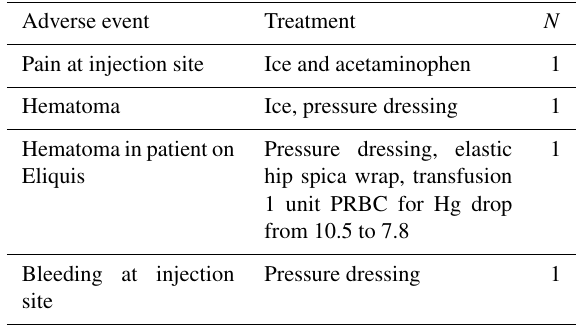
Table 3. Adverse events with treatment. Table 4. Hip aspiration cultures without growth of organism discor- dant with surgical cultures with at least one positive